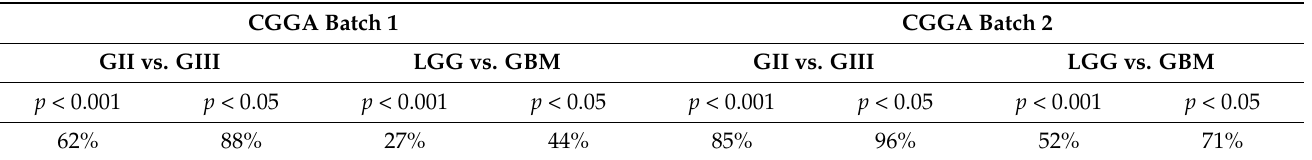
Table 2. The results of DEG list validation with CGGA cohorts. p values in validation cohorts were FDR-adjusted. CGGA Batch 1 CGGA Batch 2 GII vs. GIII LGG vs. GBM GII vs. GIII LGG vs.